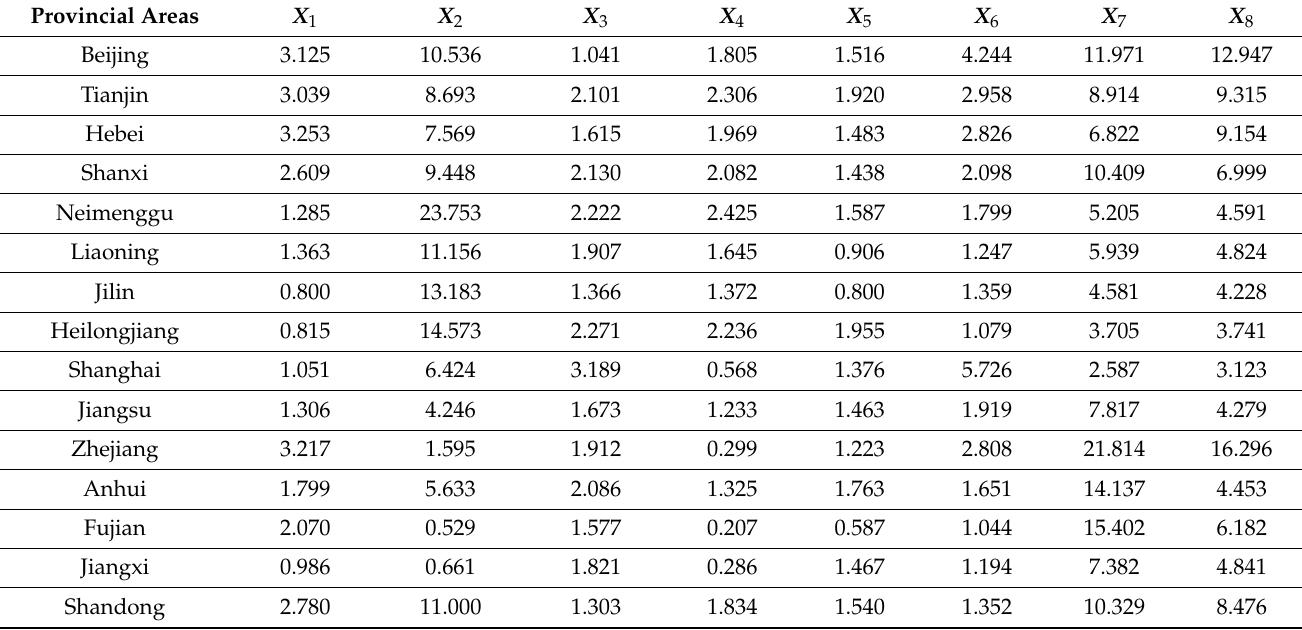
Table 3. Data of 31 provincial areas in